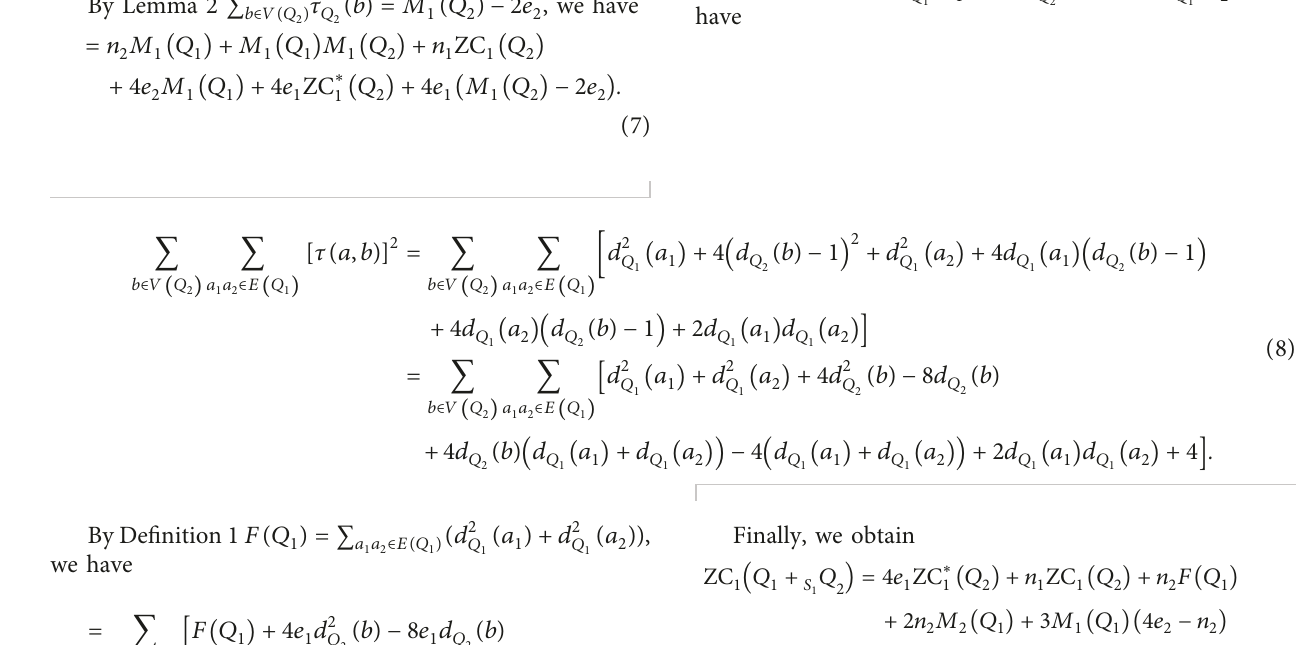
+ Q iff S � S s 1 2